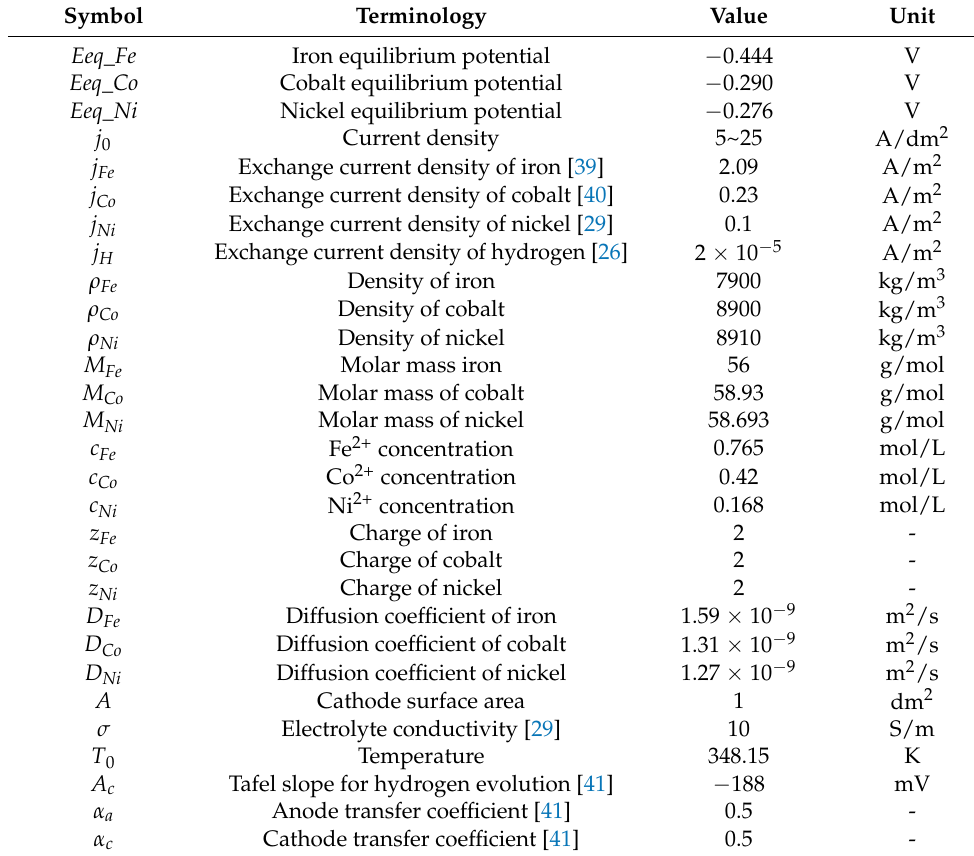
Table 2. Physical parameters and initial conditions. Symbol